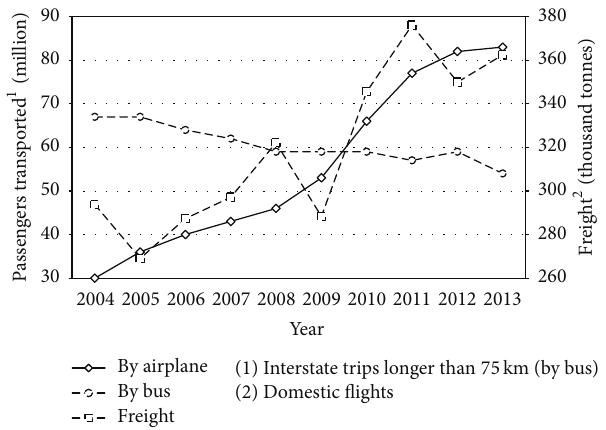
Figure 1: Evolution of passenger and freight transportation in Brazil (2004–2013) [31].